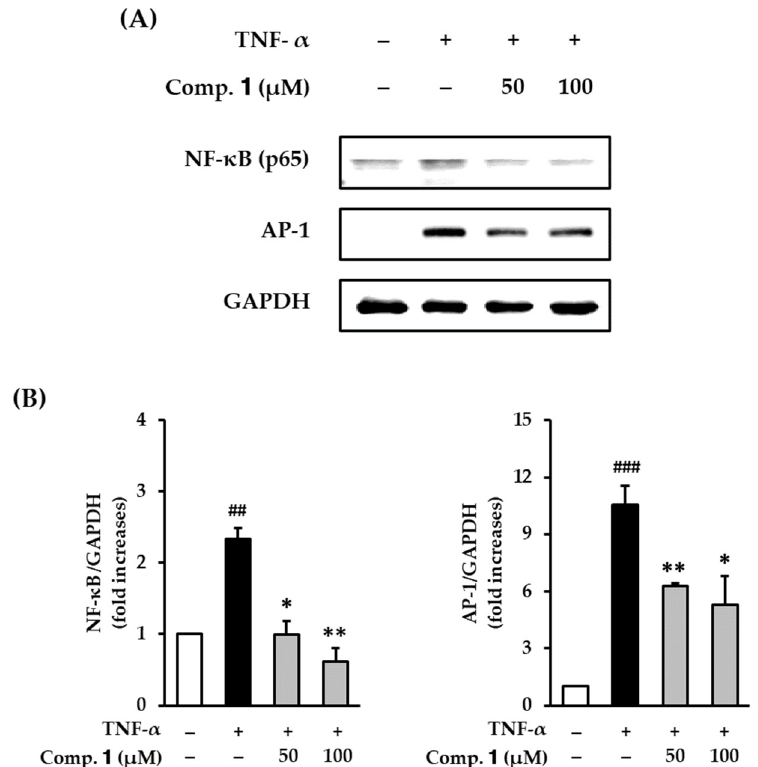
Figure 6. Effects of 1,3-dihydroxy-2,8-dimethoxy-6-methylanthraquinone ( 1 ) on NF- κ B and AP-1 protein expression in TNF- α -stimulated HDFs. HDFs were untreated or treated with TNF- α , followed by treatment with 1 for 12 h. Protein levels were determined using Western blot analysis. ( A ) Protein expression of NF- κ B, AP-1, and GAPDH. ( B ) Relative protein expression levels of NF- κ B and AP-1. The data are presented as mean ± SEM of from three independent experiments. ## p < 0.01 and ### p < 0.001 difference compared to untreated cells. * p < 0.05 and ** p < 0.01 difference compared to TNF- α -stimulated cells.